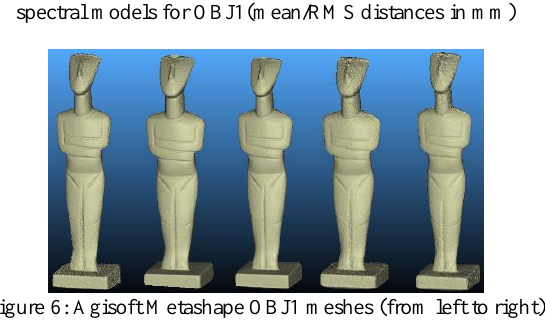
Figure 6: Agisoft Metashape OBJ1 meshes (from left to right)